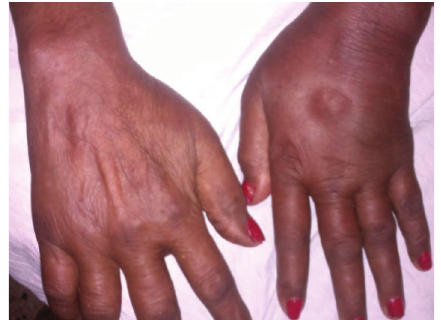
Figure 1: Showing clinical photograph of the patient.